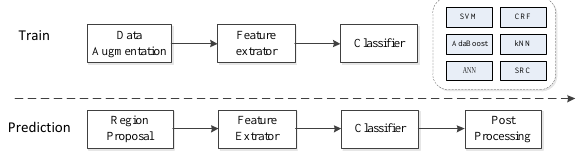
Figure 1. Framework of machine Learning based object detection